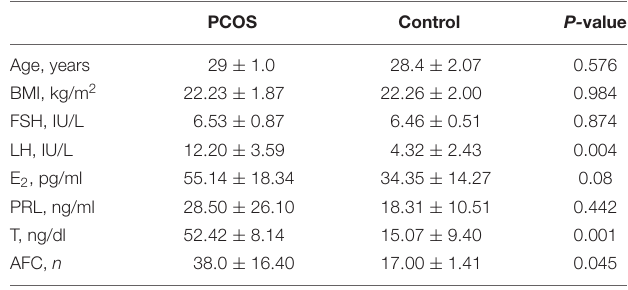
TABLE 1 | Clinical characteristics of women with polycystic ovary syndrome and